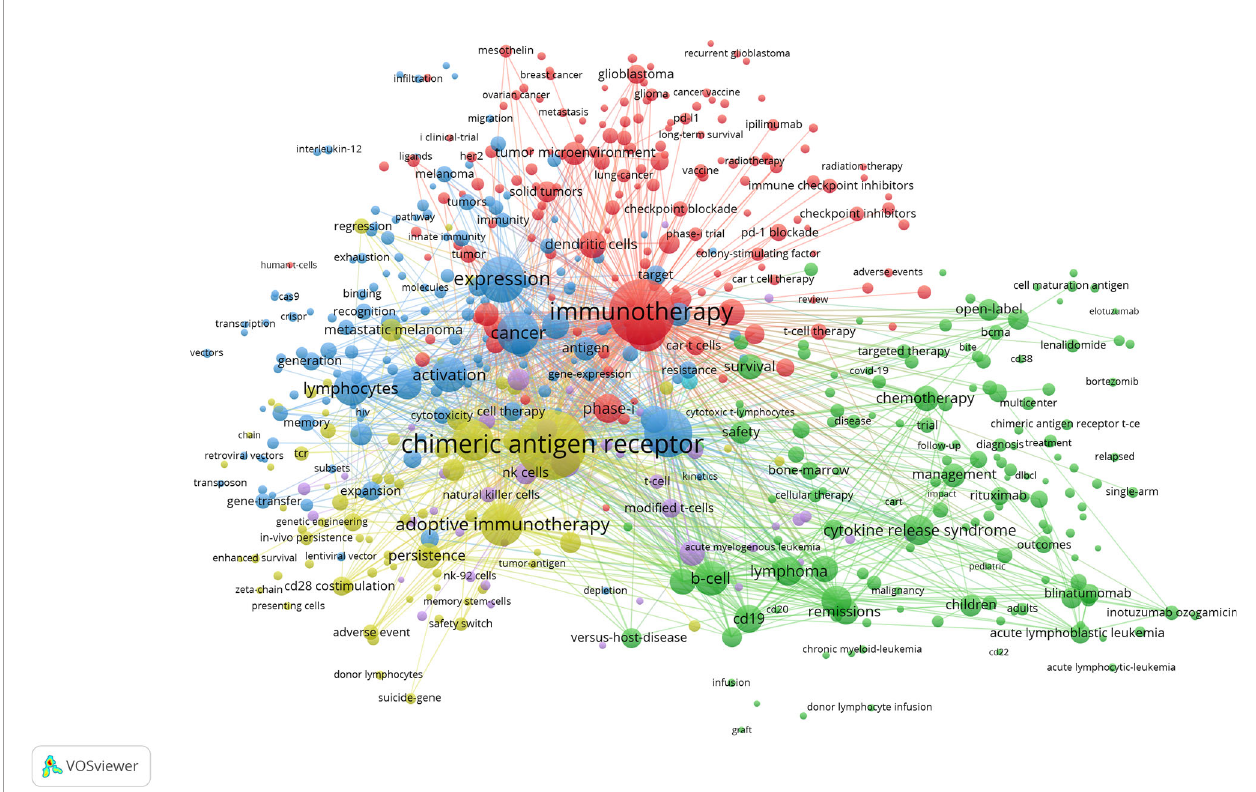
FIGURE 8 | The co-occurrence network and clusters of keywords related to CAR-T cell research. Minimum number of occurrences of keywords ≥